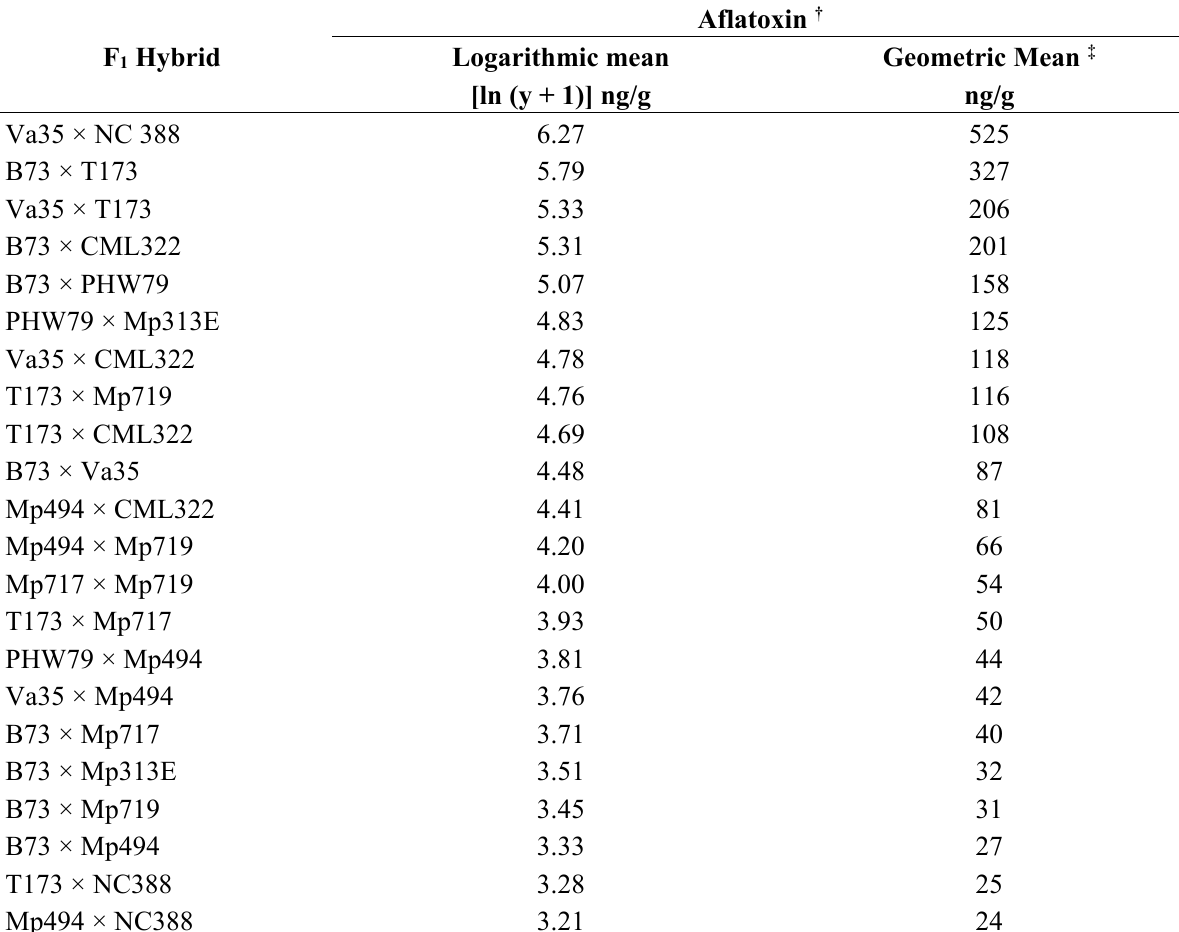
Table 2. Mean aflatoxin accumulation in 45 F1 hybrids constituting a diallel cross grown at Mississippi State in 2013 and